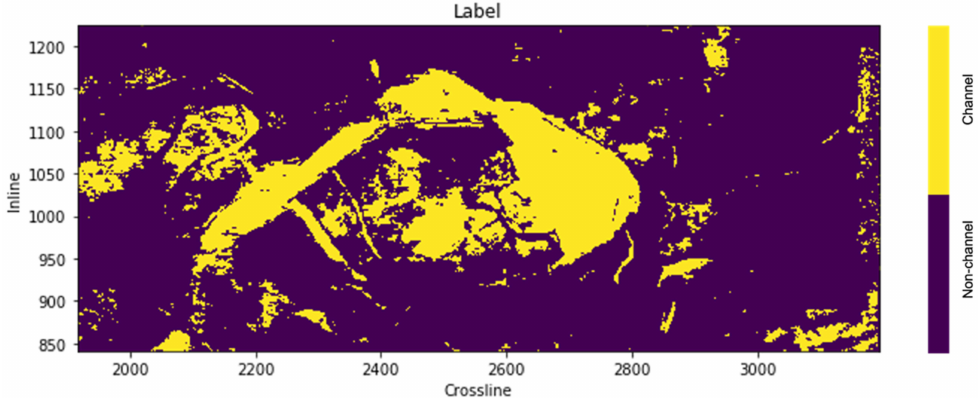
Figure 21. The ground truth data, generated from the clustering result.